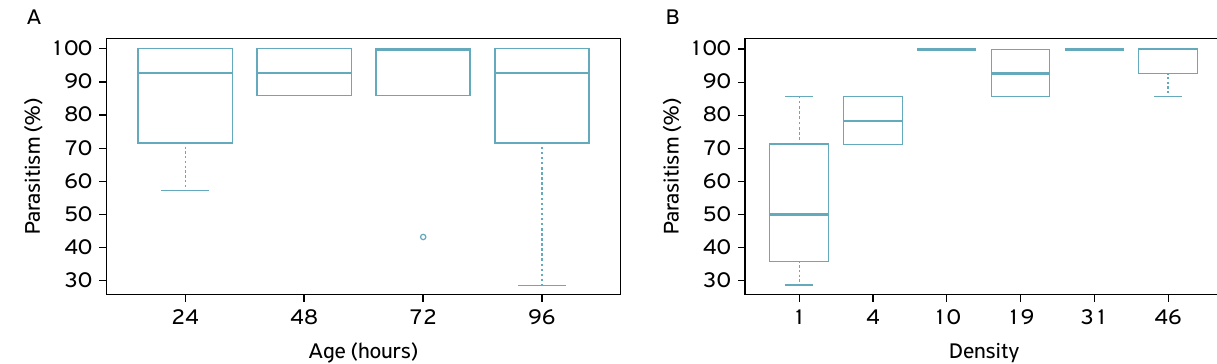
Figure 1. Parasitism (%) of Palmistichus elaeisis (Hymenoptera: Eulophidae) at (A) different host ages and (B) different parasitoid densities (25 ± 2°C, 70 ± 10% relative humidity and 12 hours photoperiod).